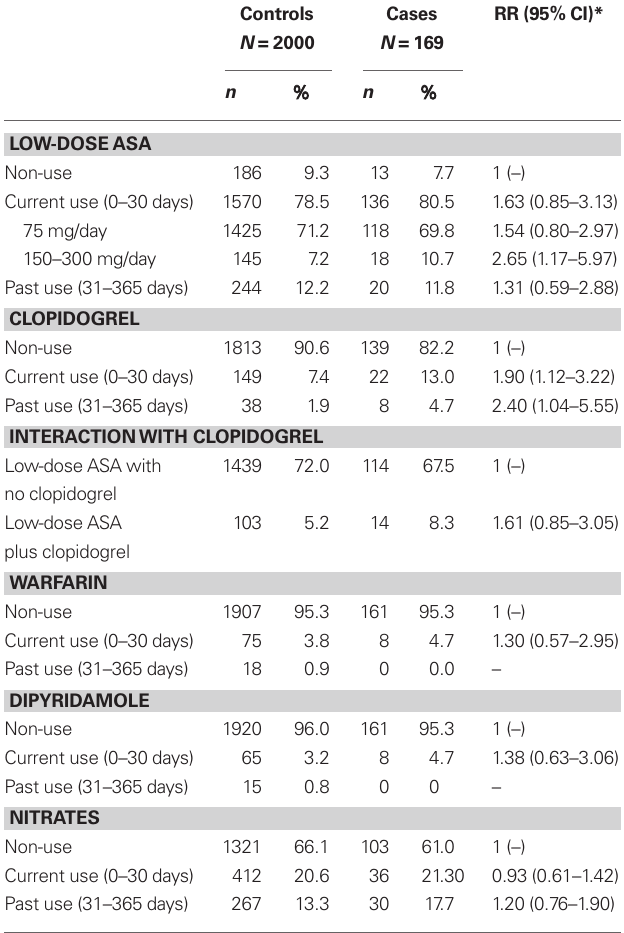
Table 2 | medication use in individuals with ugiB and controls with no ugiB, and their association with a diagnosis of ugiB, in a cohort of low-dose ASA users.